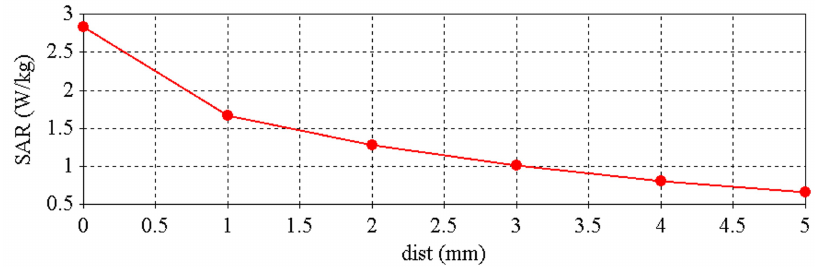
Figure 17. SAR at 2.4 GHz when varying the separation between the antenna and phantom.